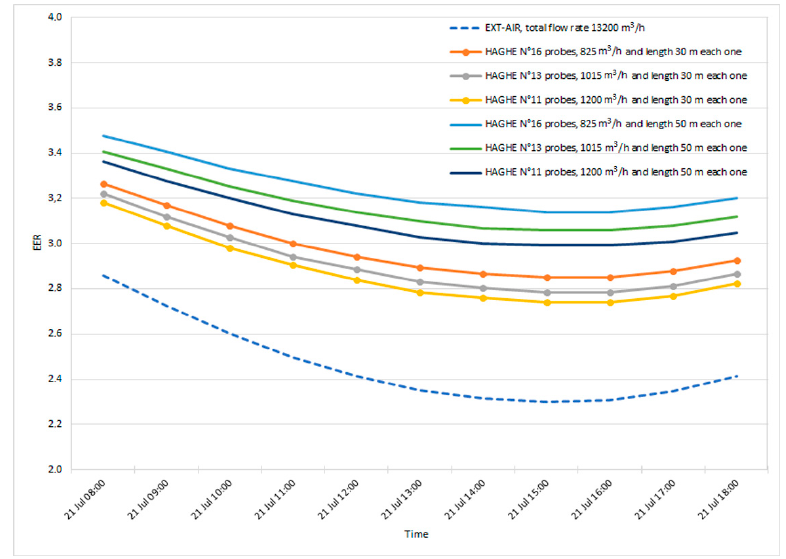
Figure 10. Comparison, in the hottest day, between EER EXT ‐ AIR and EER HAGHE by varying air flow rate and probe length: 21 July, T w = 6 °C, ground humidity = 40%, H = 3 m.